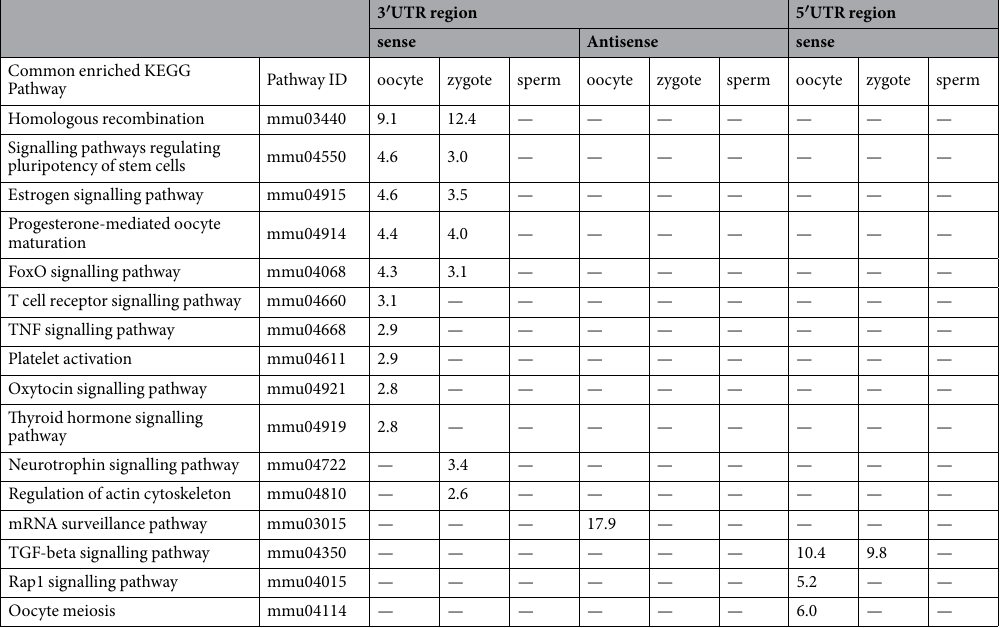
— — — — — 6.0 — — Table 5. Enriched KEGG pathway transcripts implicated in fertilization and immune system with 3 ′ and 5 ′ UTR associated NRapiRNAs. Numbers indicate the fold enrichment value of pathways after DAVID enrichment analysis using transcripts with NRapiRNAs associated to their 3 ′ and 5 ′